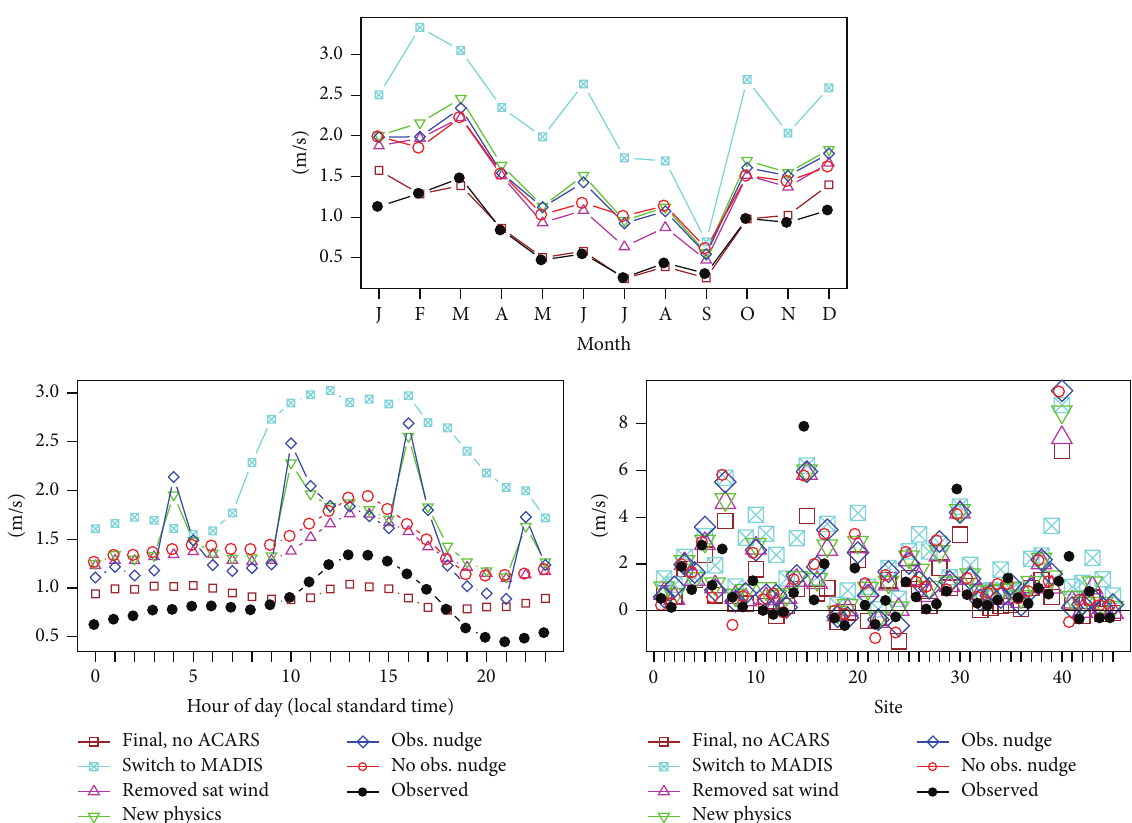
Figure 3: Mean values of U, the east-west component of the wind vector, for several WRF cases, by month, by hour, and by site. The sites are shown in Figure 2(a). The colored lines in the key represent results from different WRF cases from the earliest and simplest at the end to the final at the beginning. The black line is the observed